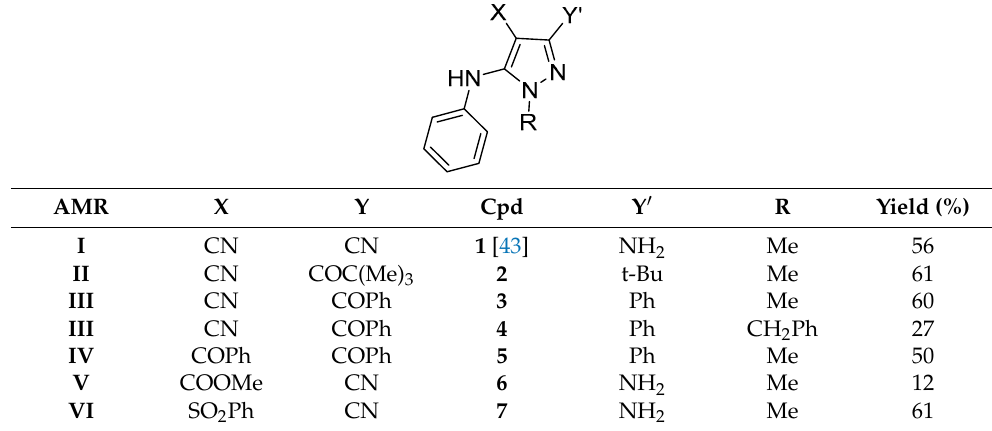
Table 1. Synthesized pyrazoles and active methylene reagents employed in the synthesis.